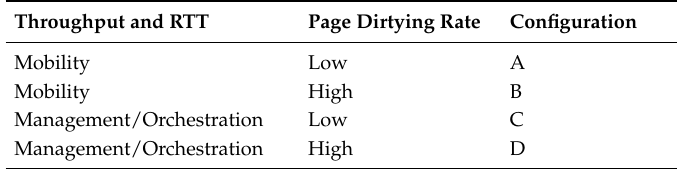
Table 3. How values were combined to obtain the four